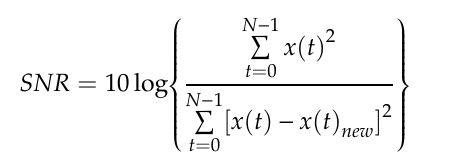
Figure 8. Four methods for denoised of the Ricker waveform and their spectra.